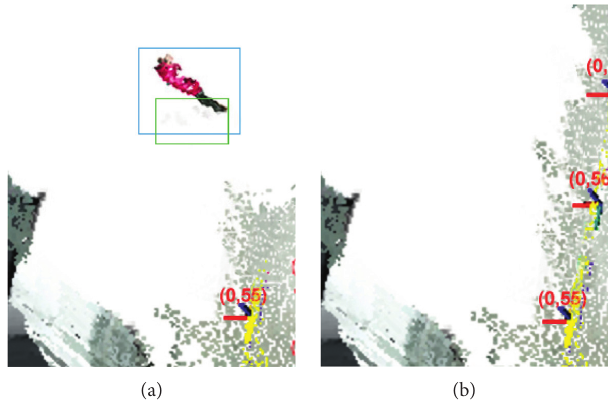
Figure 6: Dynamic object removal. (a) Before removal, the foot of the woman in red is detected, leaving a gray occupying grid and point cloud in the generated submap. (b) After removal, the woman in red walked through the machine and not appeared on the point cloud again. The Cartographer algorithm used formula (2) to update the occupied grid of basket position in (a) to the non- occupied state, and the proposed algorithm in section C removes the point cloud of the woman in red.